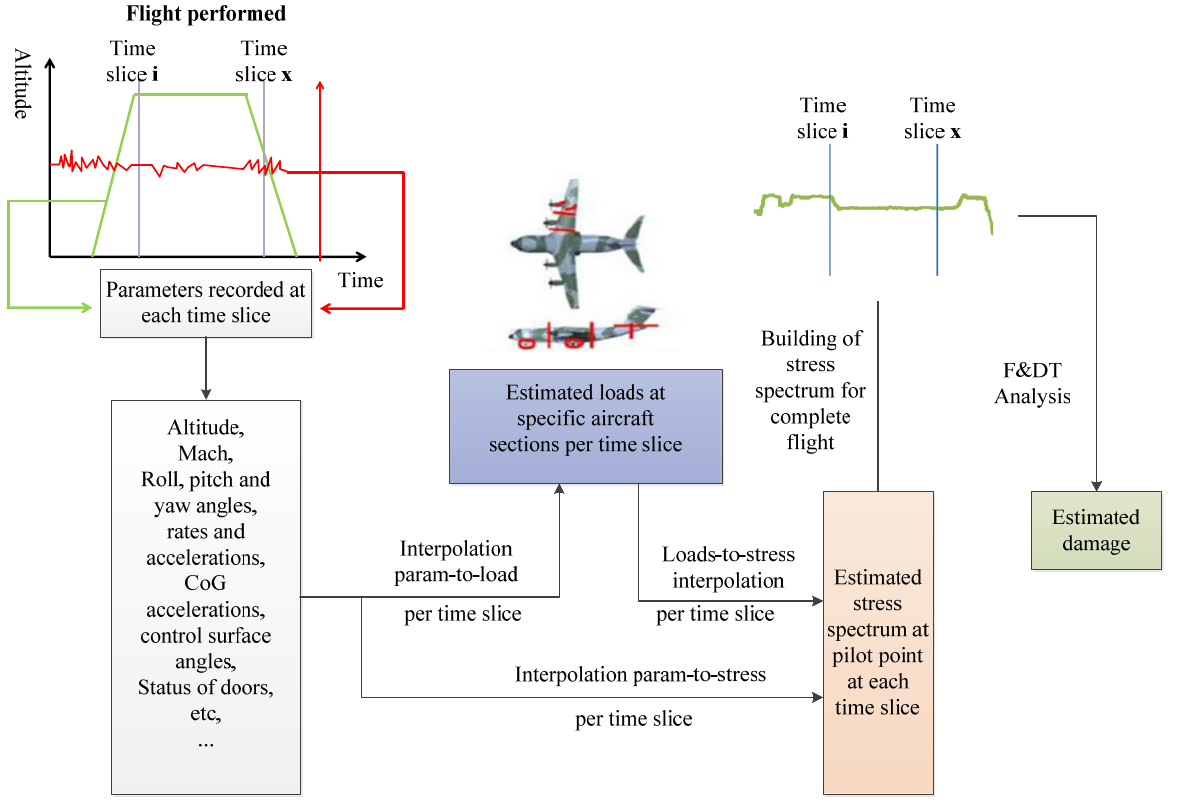
Figure 4. The usage monitoring function process for A400M.